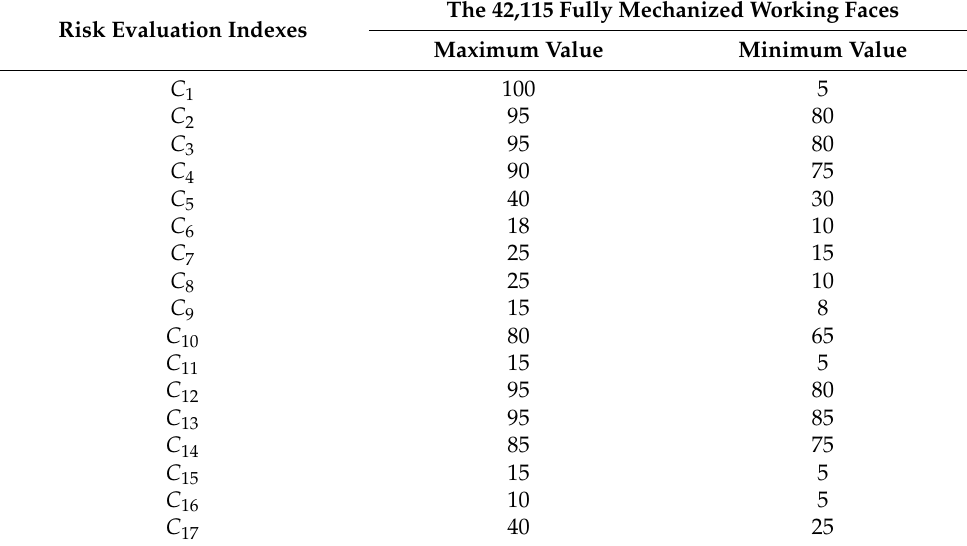
Table 9. Overview of all indexes of the 42,115 fully mechanized working faces. Risk Evaluation